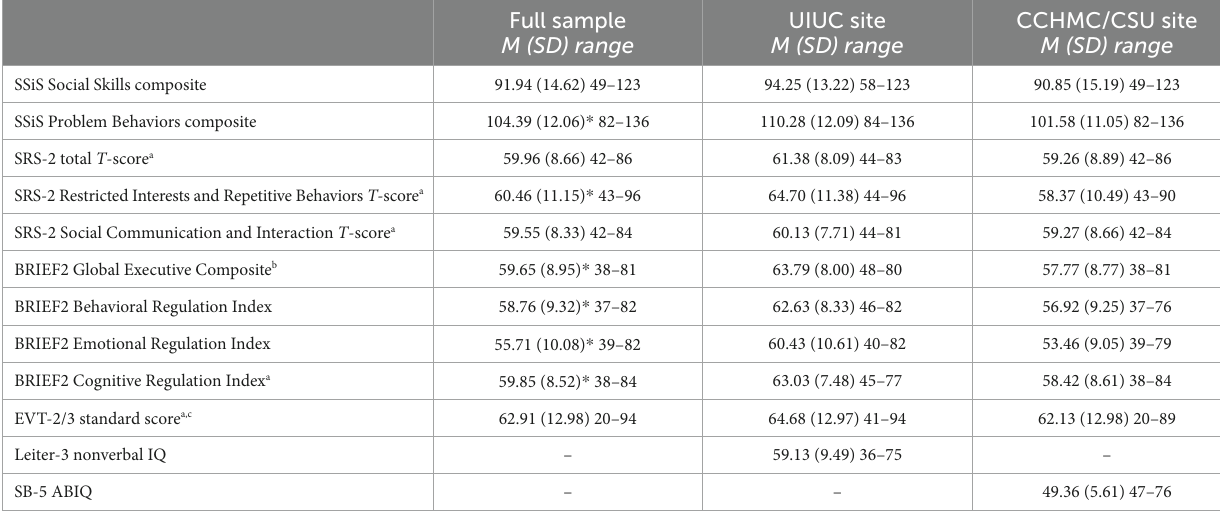
TABLE 2 Participant performance on study